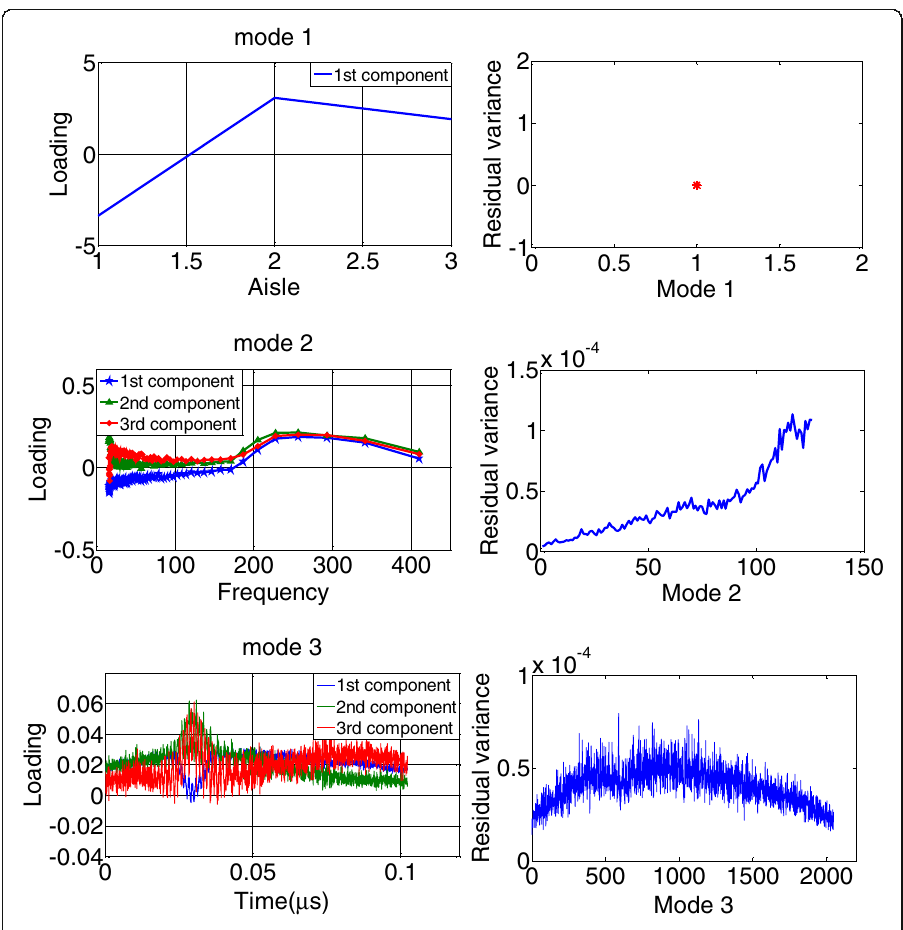
Fig. 9 Parallel factor analysis of noise added simulation